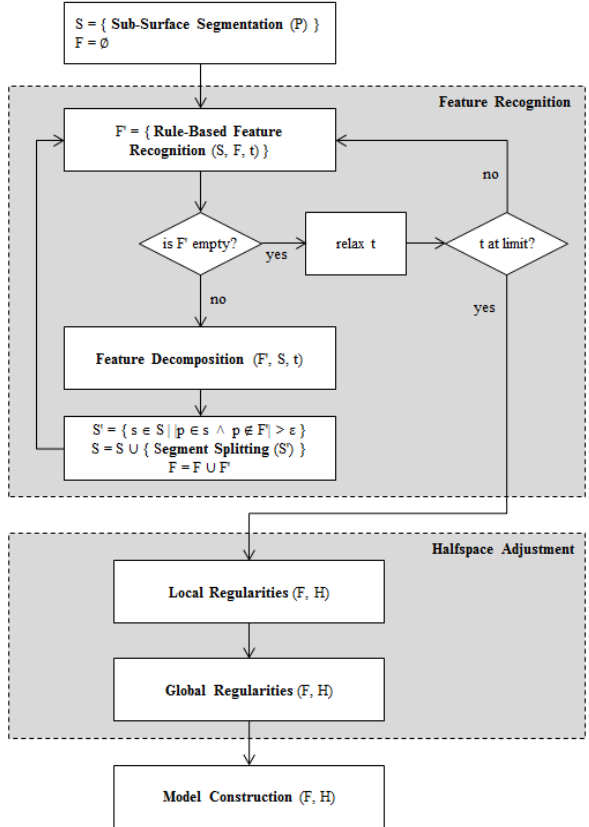
Figure 1. The reconstruction process (P = set of input points, S = set of segments, F = set of features, H = set of half-spaces, t = thresholds for feature recognition).